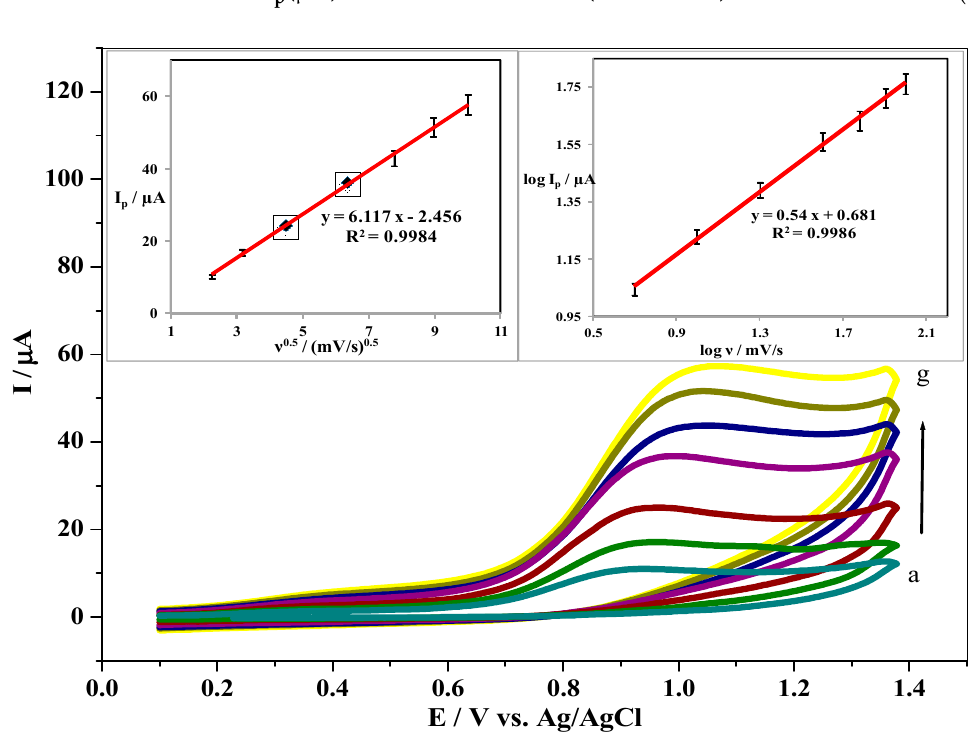
Figure 9. CVs of 3.5 mM of NIC in 0.1 M of Na 2 SO 4 (pH 8.0) at the GO/Nq/GCE with various scan rates (a to g: 5, 10, 20, 40, 60, 80, and 100 mV/s).